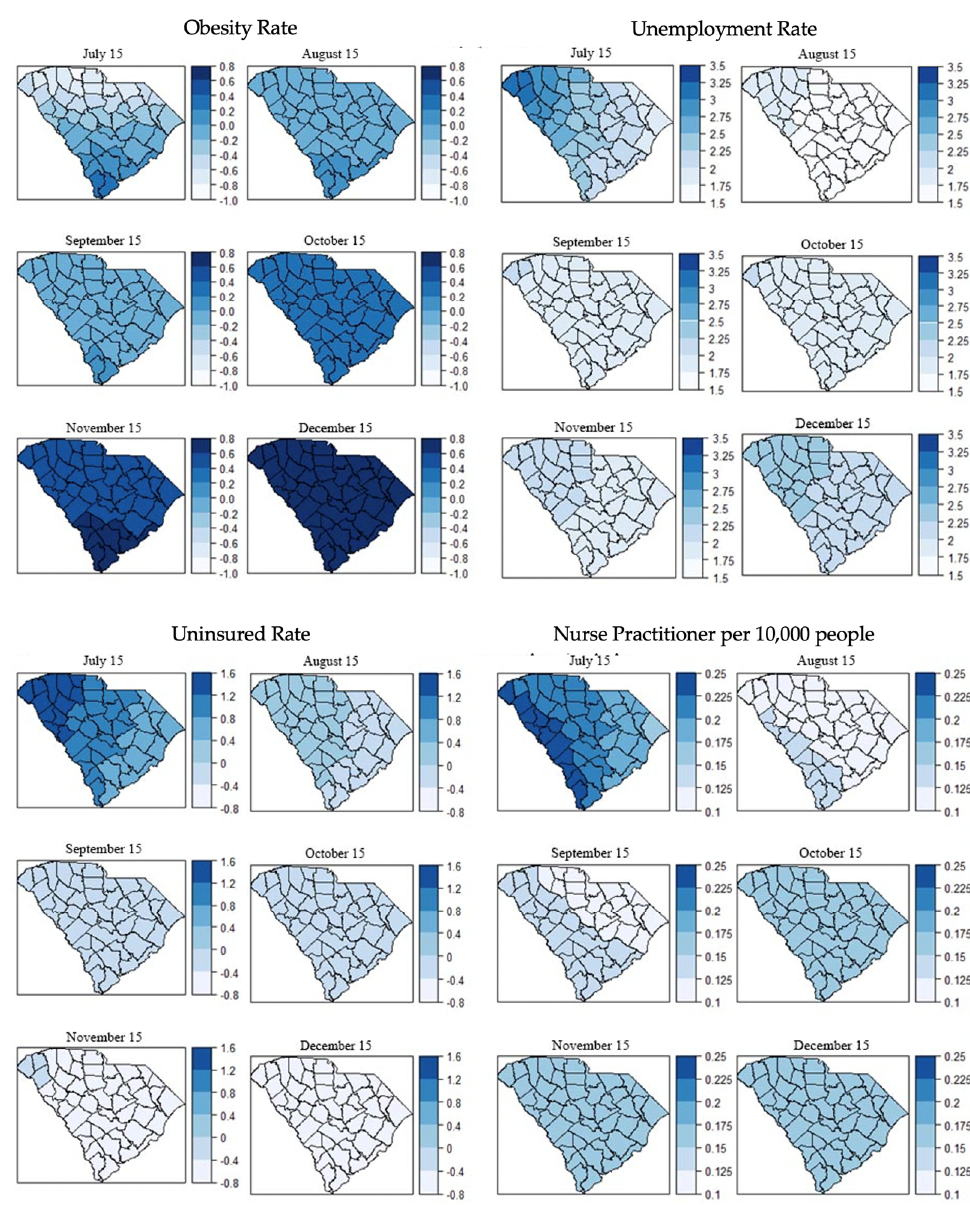
Figure 3. Monthly geographic distribution of local coefficient estimates of GWR models for